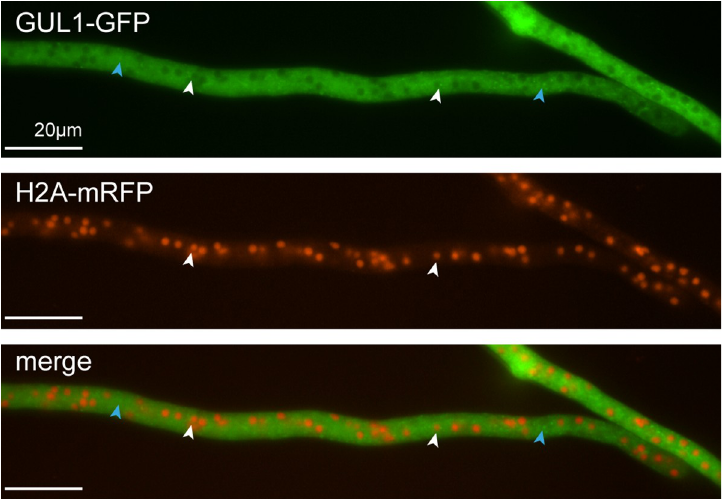
Fig 6. Localization of GUL1-GFP and H2A-mRFP in hyphae of Δ gul1. GUL1 localizes in dot-like structures within the cytoplasm (blue arrows). White arrows indicate a localization of GUL1 close to the nucleus (see also S1 Movie).